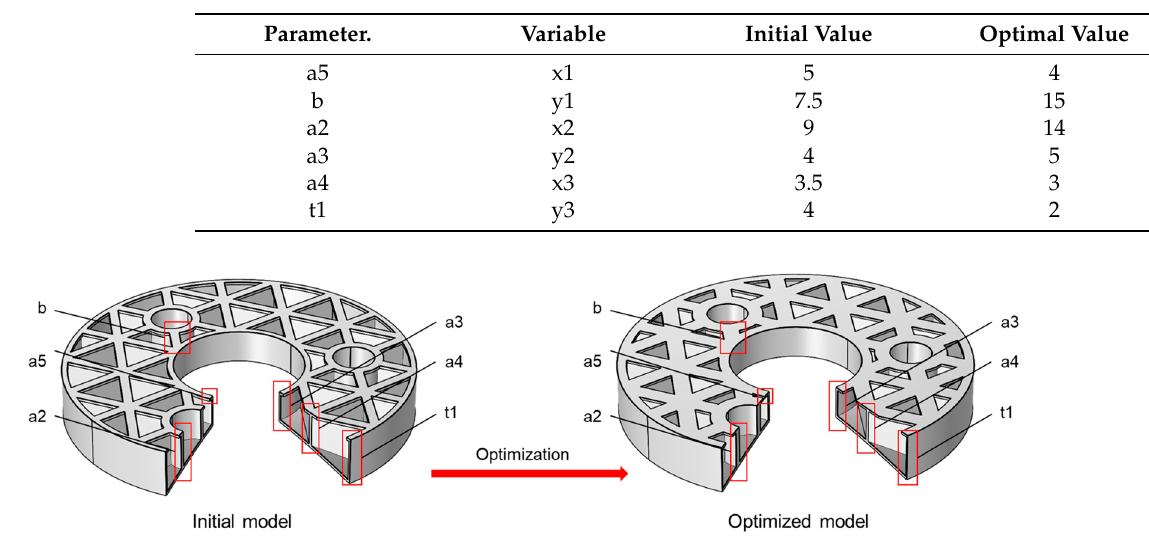
Figure 9. Comparison of the initial mirror and the optimized mirror.